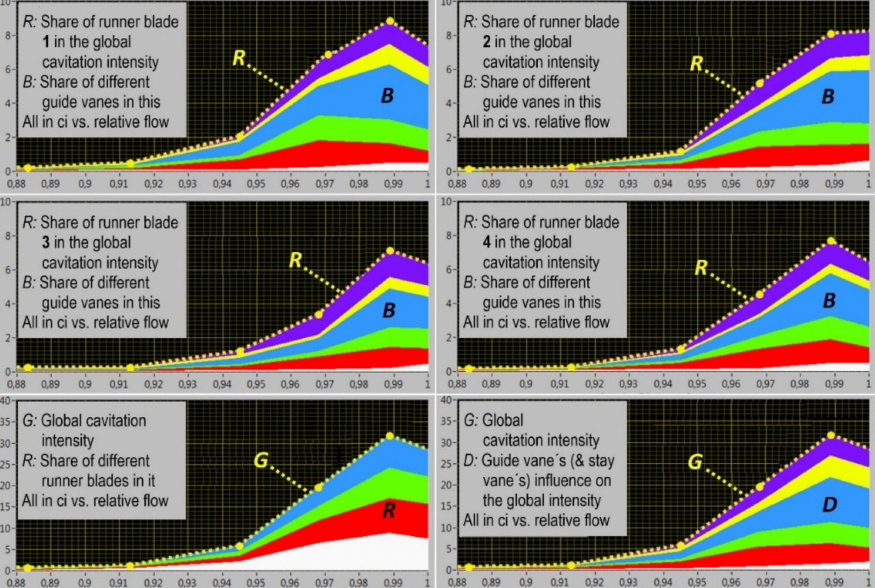
Figure 10. Four types of introductory turbine cavitation characteristics (the model of the turbine in operation, on specific head and cavitation-number values), all expressed as components of the mean global cavitation characteristic I (